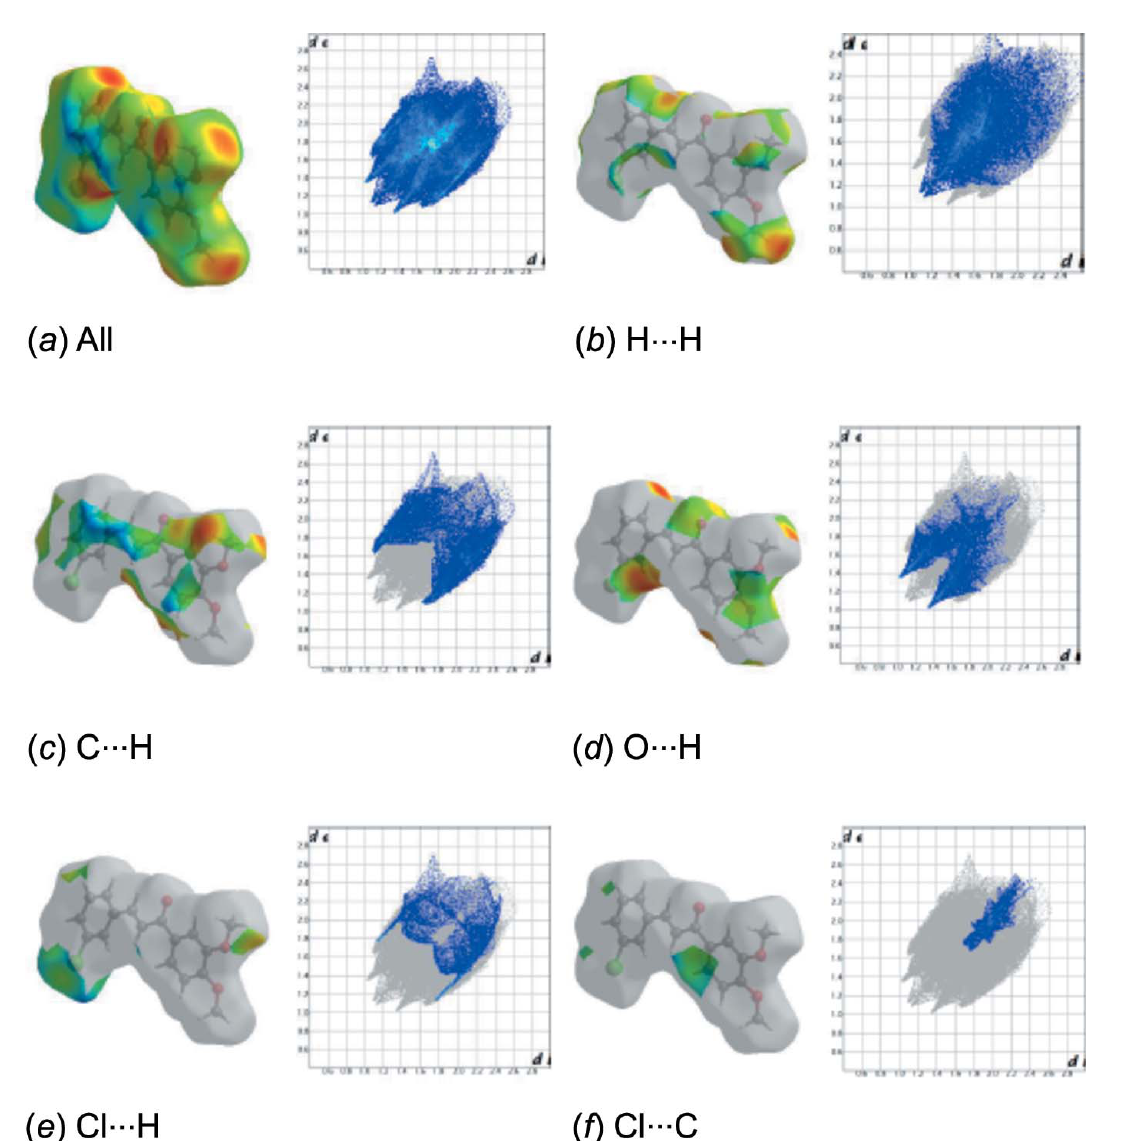
Figure 5 The two-dimensional fingerprint plots of the title compound, showing ( a ) all interactions, and delineated into ( b ) H (cid:3)(cid:3)(cid:3) H, ( c ) C (cid:3)(cid:3)(cid:3) H, ( d ) O (cid:3)(cid:3)(cid:3) H, ( e ) Cl (cid:3)(cid:3)(cid:3) H and ( f ) Cl (cid:3)(cid:3)(cid:3) C interactions [ d e and d i represent the distances from a point on the Hirshfeld surface to the nearest atoms outside (external) and inside (internal) the surface, respectively].